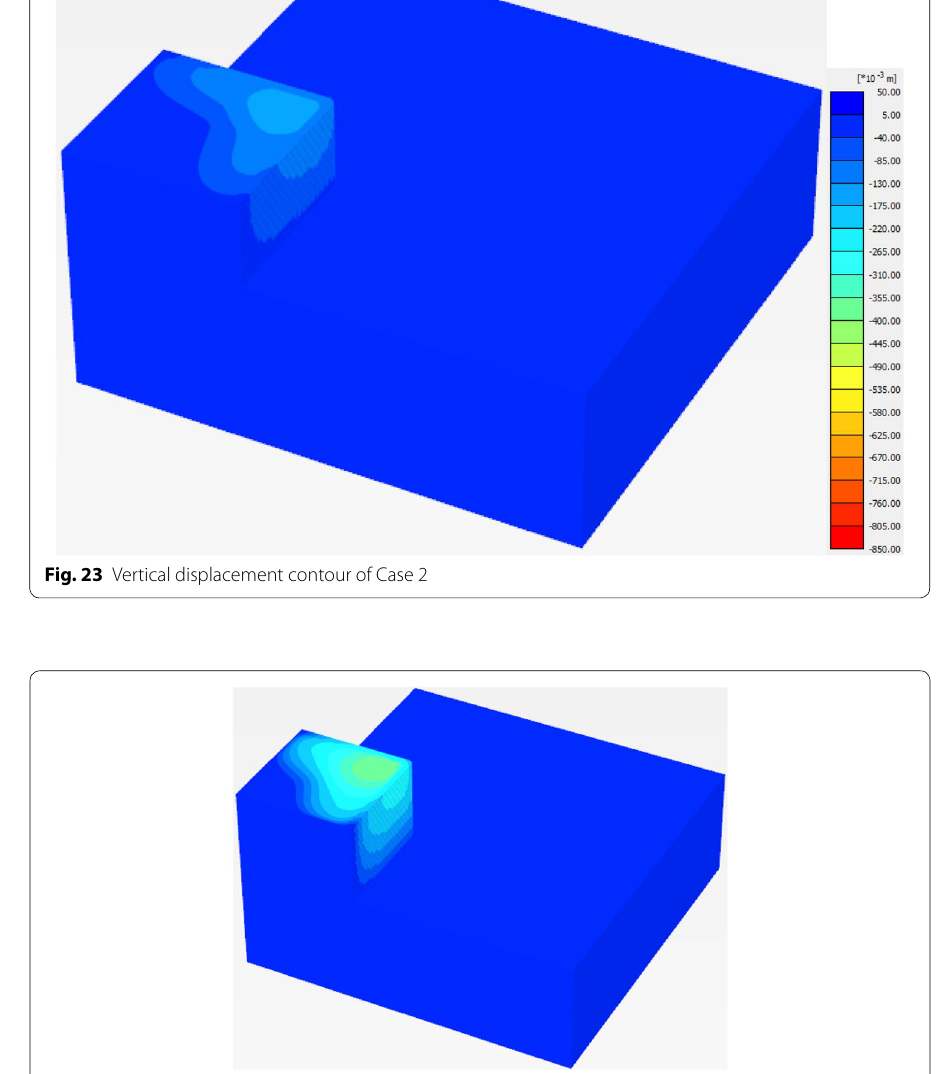
Fig. 24 Vertical displacement contour of Case